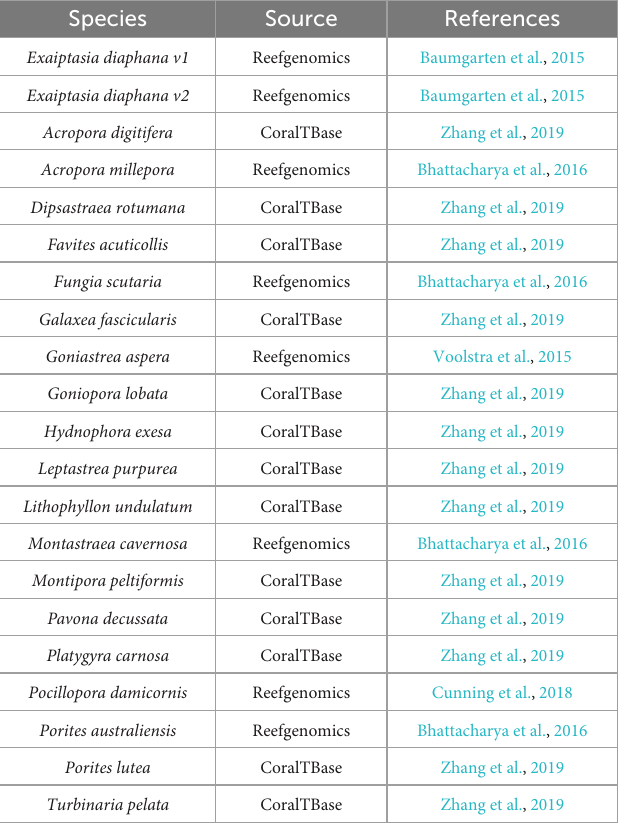
TABLE 2 The anthozoan datasets used for